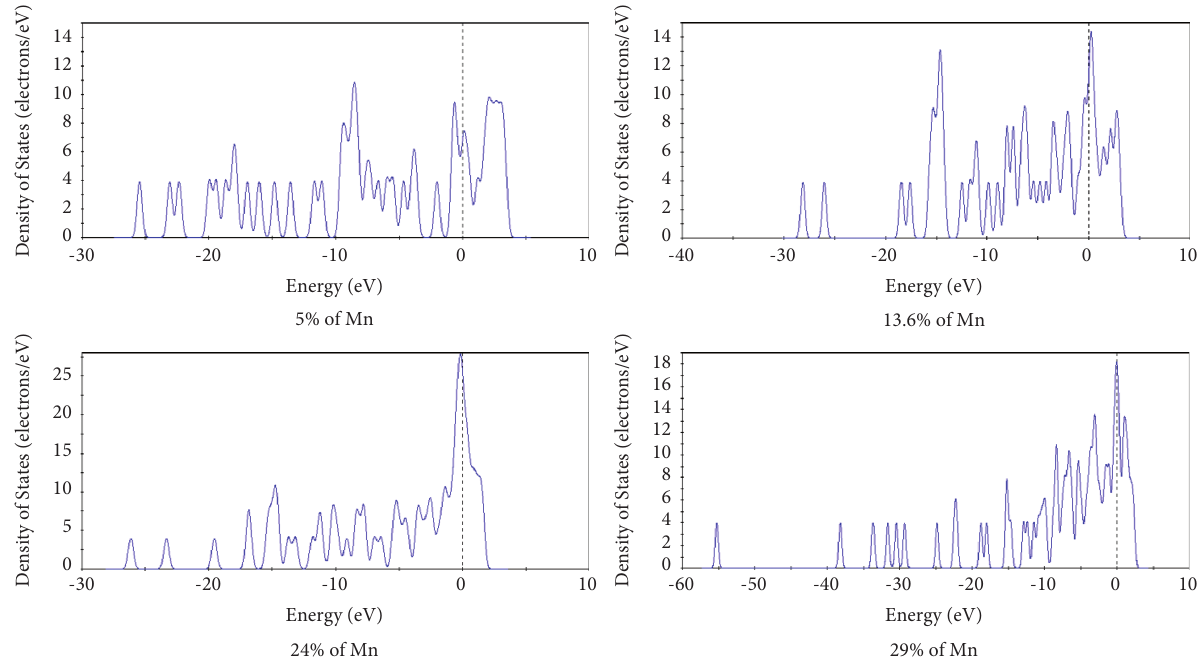
Figure 1: The density of states of InSb–Mn with Mn � 5%, Mn � 13.6%, Mn � 24%, and Mn �